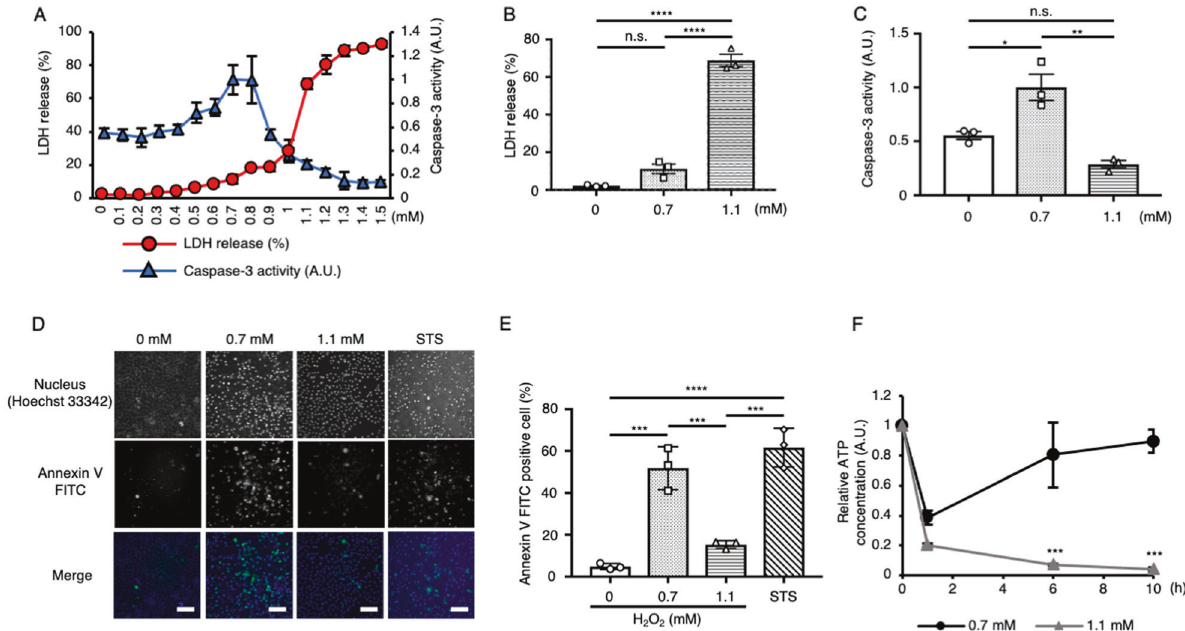
Fig. 1 The intracellular ATP concentration is recovered only under weak H 2 O 2 stimulation. A LDH release into the conditioned medium and caspase-3 activity of HeLa cells stimulated with various concentrations of H 2 O 2 for 30 h and 10 h, respectively ( n = 3). B LDH release after 0, 0.7 and 1.1 mM H 2 O 2 stimulation (data extracted from panel A ). C Caspase-3 activity after 0, 0.7 and 1.1 mM H 2 O 2 stimulation (data extracted from panel A ). D Representative images of Annexin V-stained HeLa cells stimulated with H 2 O 2 or STS for 20 h. Blue; Hoechst 33342,